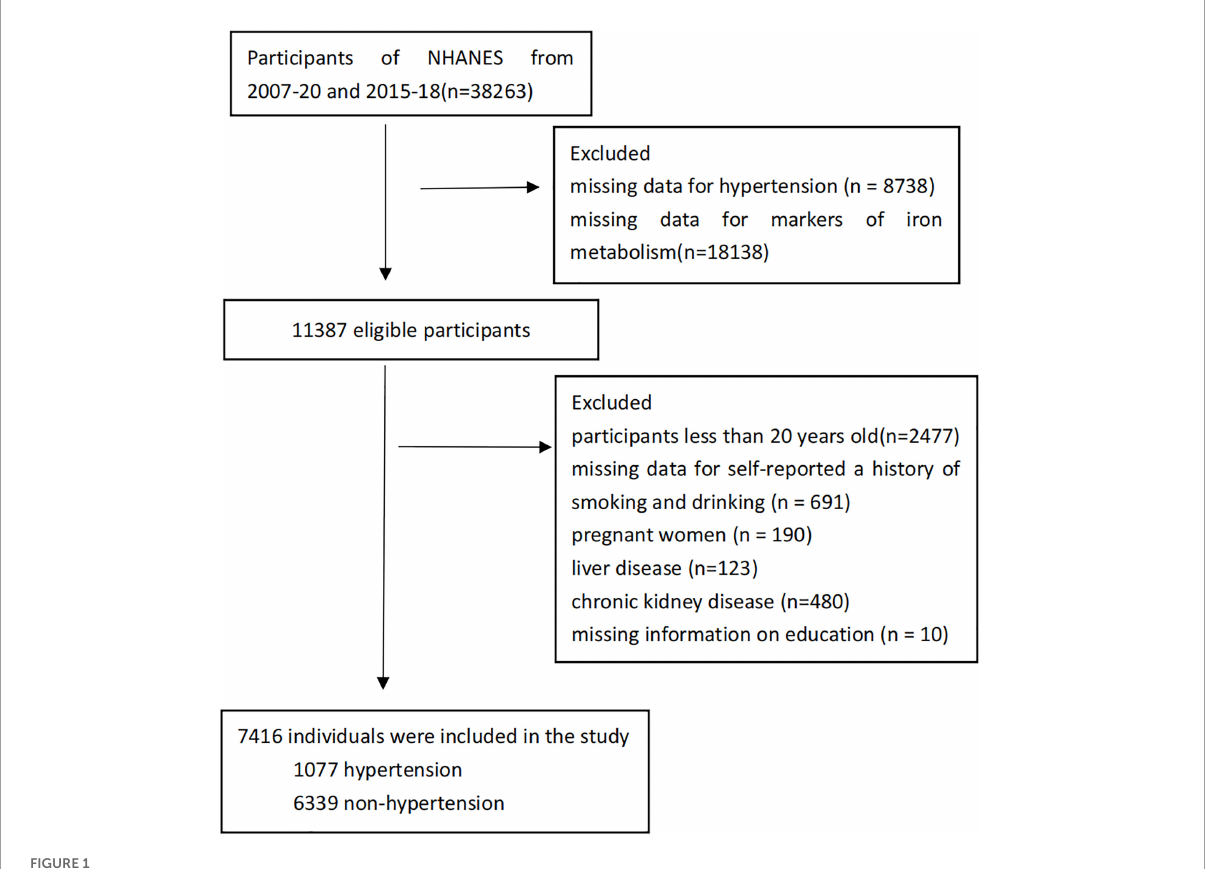
FIGURE1 Flowchart of participant